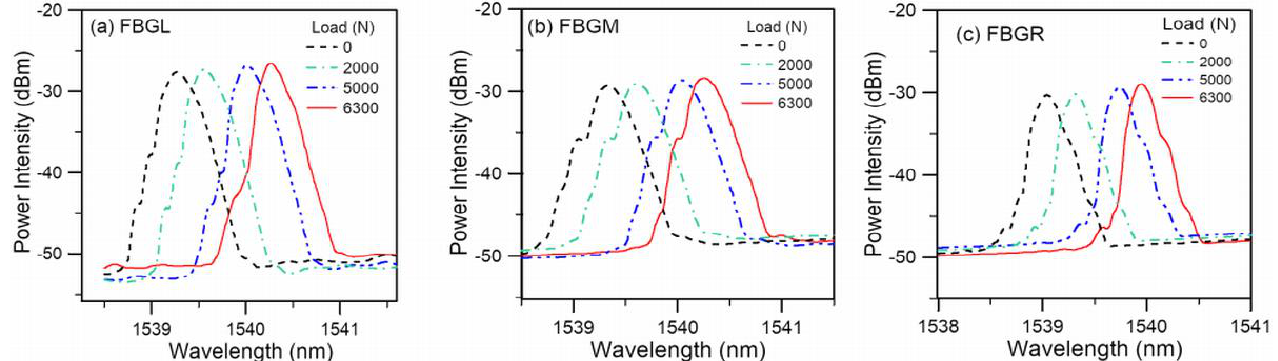
Figure 3. FBG spectra at various loadings in a typical tensile specimen.